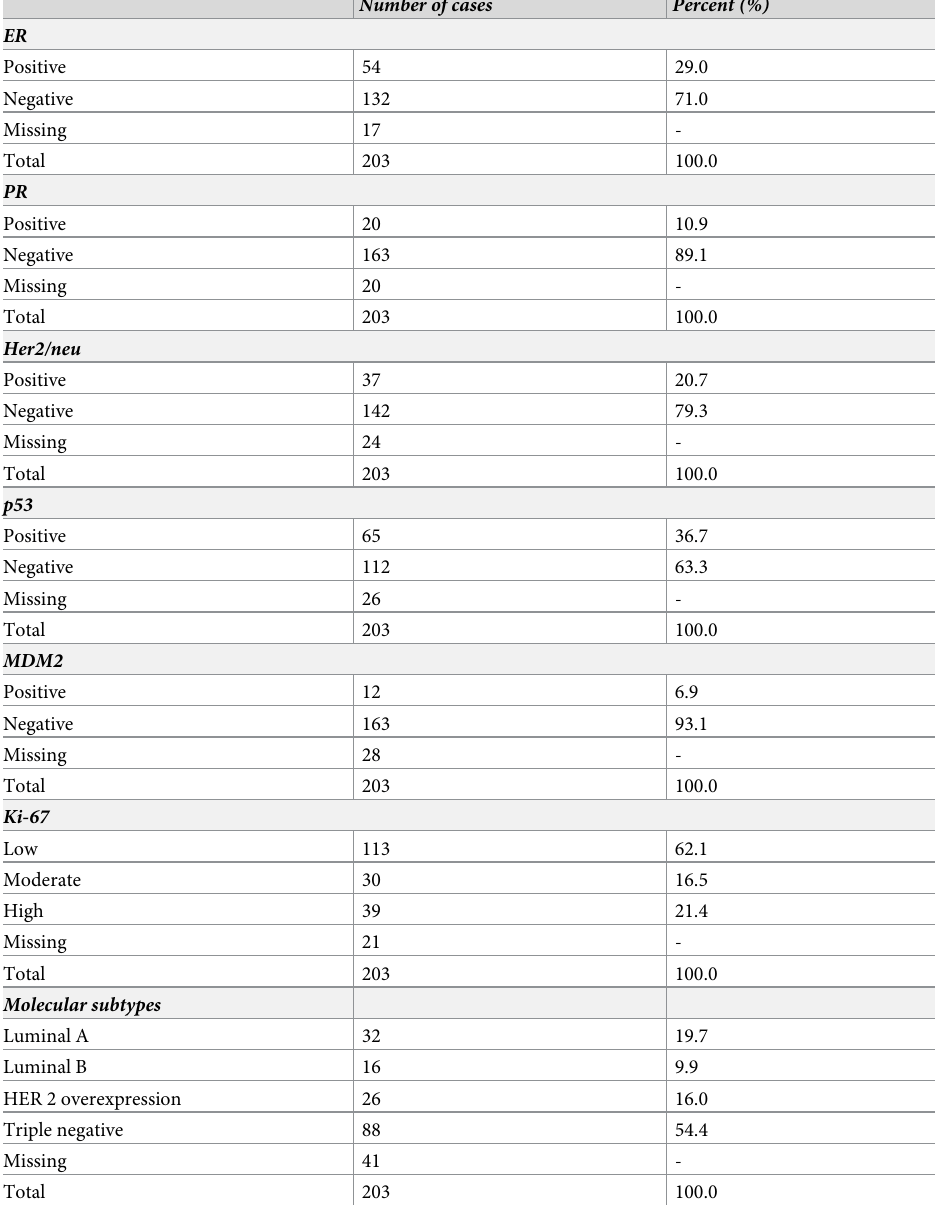
Table 3. Immunohistochemical staining results on